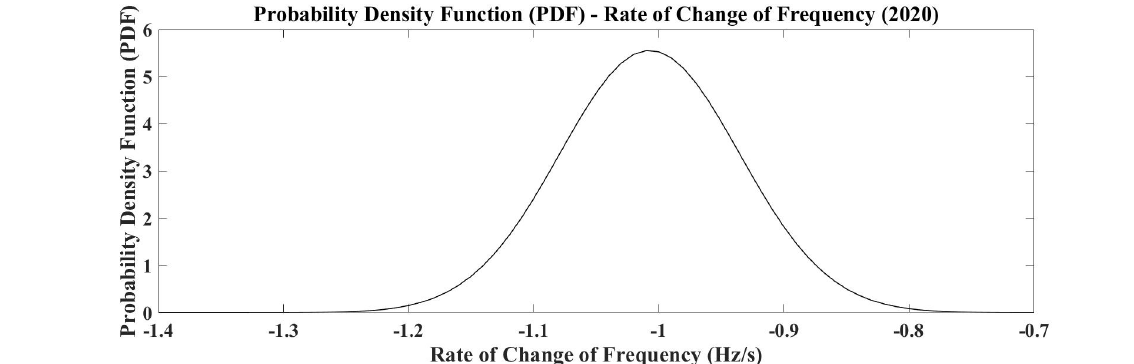
Figure 8: PDF curve of ROCOF for year 2020.